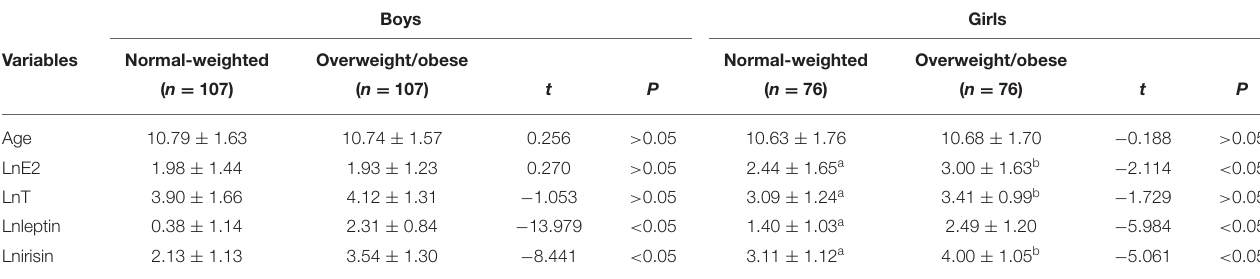
TABLE 1 | General situational analysis of research objects (Mean ± SD).